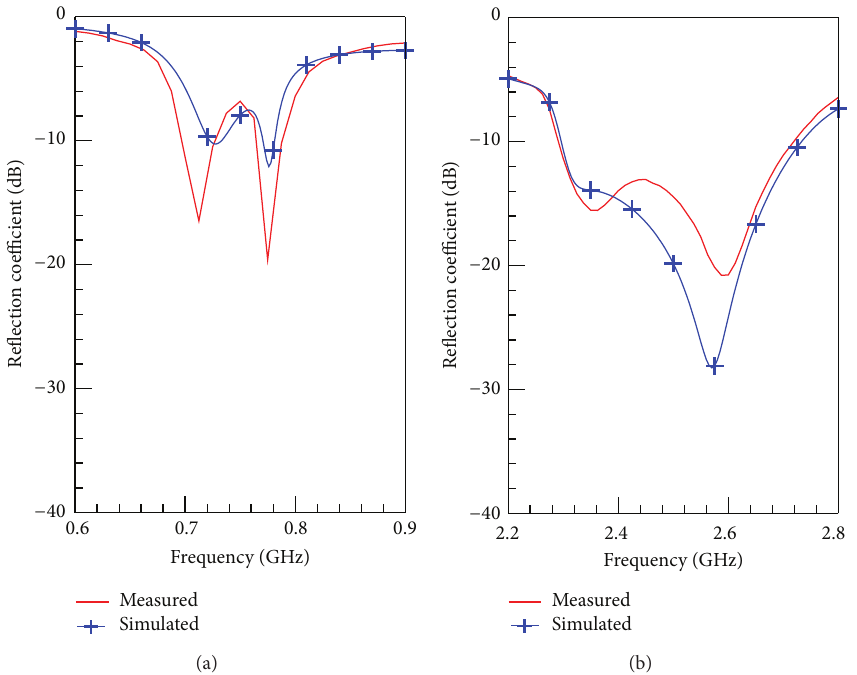
Figure 3: Measured and simulated reflection coefficient of the proposed miniaturized antenna versus frequency.